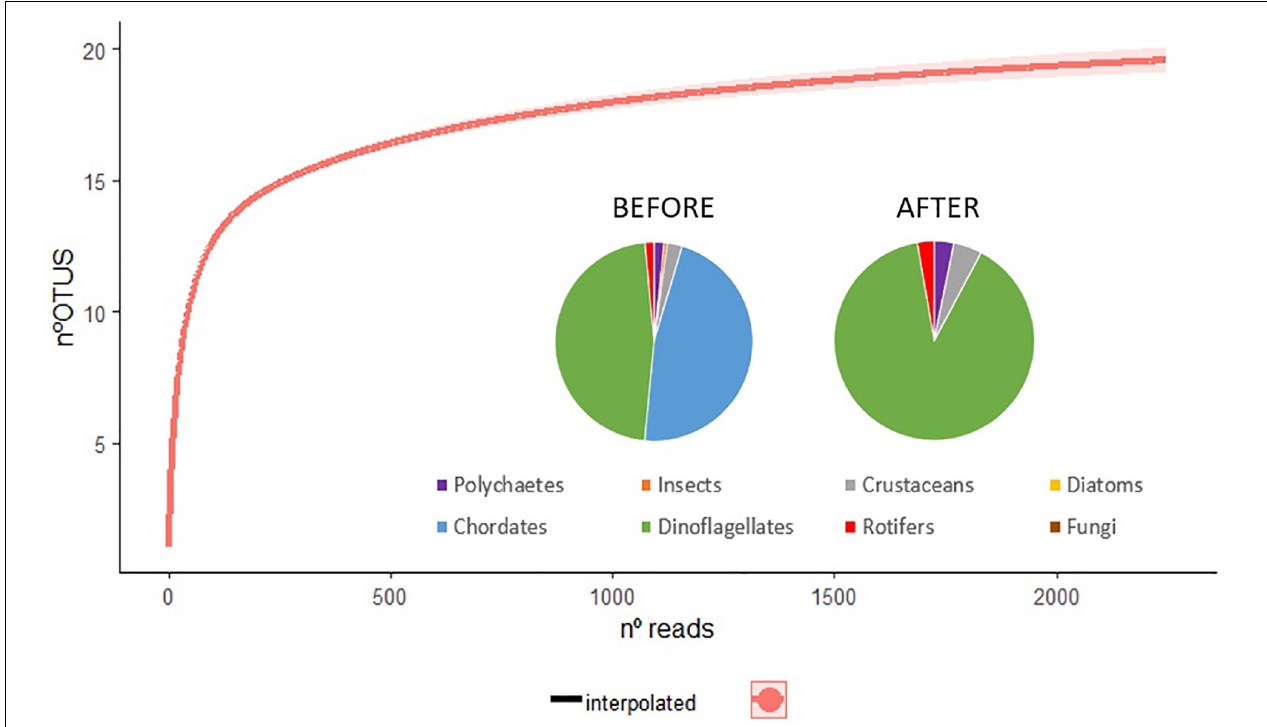
FIGURE 2 | Rarefaction curve plotting the number of reads by the number of operational taxonomic units (OTUs) for the sample analyzed using high-throughput sequencing. Interpolated line in red. Graphics with the proportion of different taxonomical groups detected in the lagoon before and after expert check (eliminating the reads assigned to terrestrial and exclusive marine